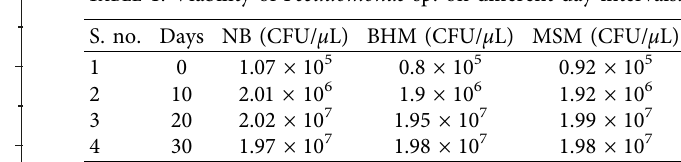
Figure 1: (a) Pure culture of Pseudomonas sp. strain. (b) Pretreated PP mask pieces. (c) PP mask placed on the culture-inoculated nutrient agar plate. (d) PP mask pieces on nutrient agar after 30 days. Table 1: Viability of Pseudomonas sp. on different day intervals.